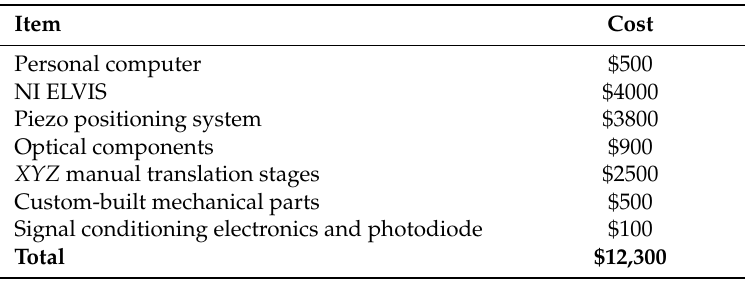
Table 1. Approximate cost of major components.